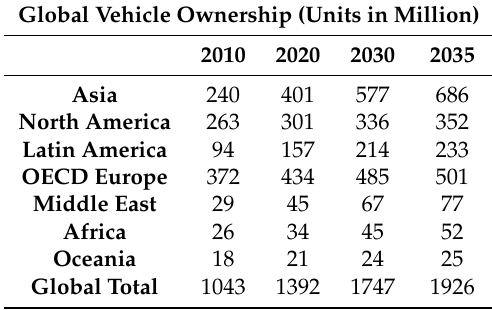
Table 1. Global vehicle ownership scenario.